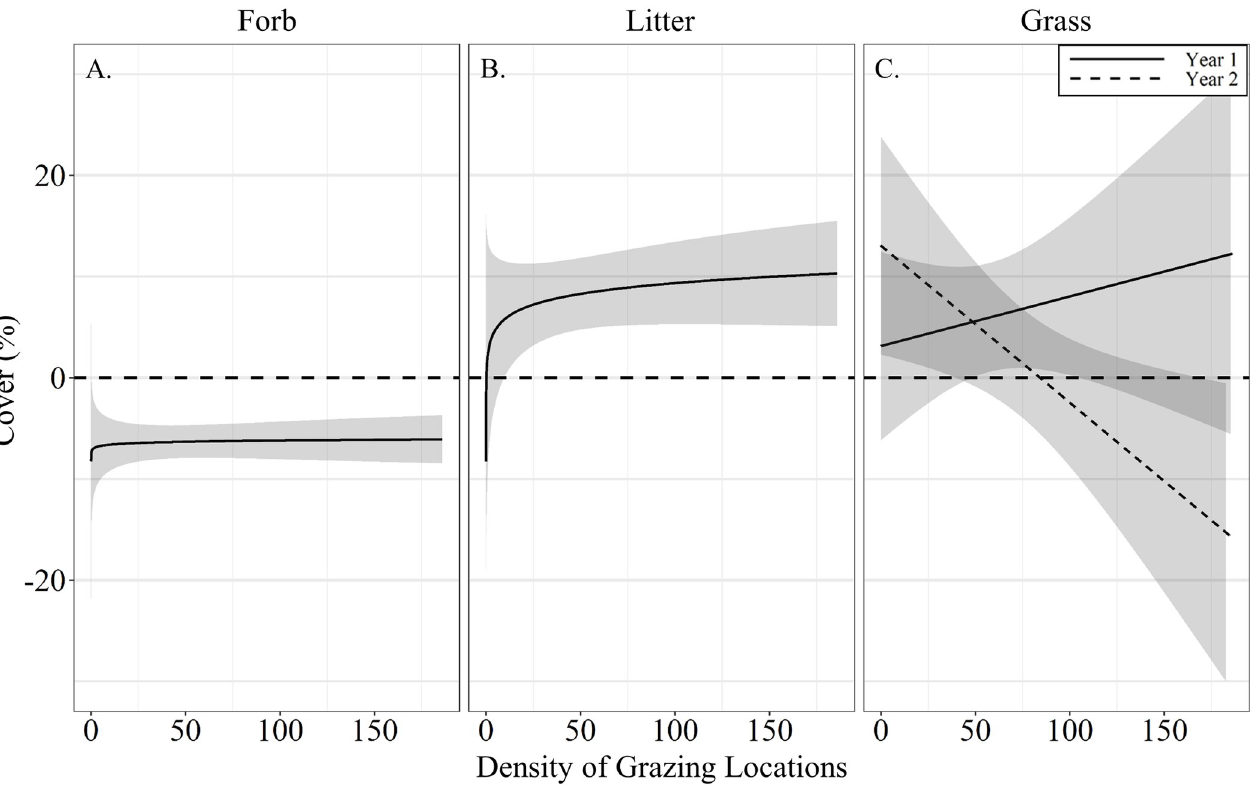
Fig 8. Predicted relationships ( ± 95%CI represented in the shaded area) of pre- post grazing differences of residual cover of ( A ) forb, ( B ) litter, ( C ) a grass by year interaction and the density of grazing locations within a 50 m radius of transect locations by cattle grazing dormant northern mixed grass rangeland in